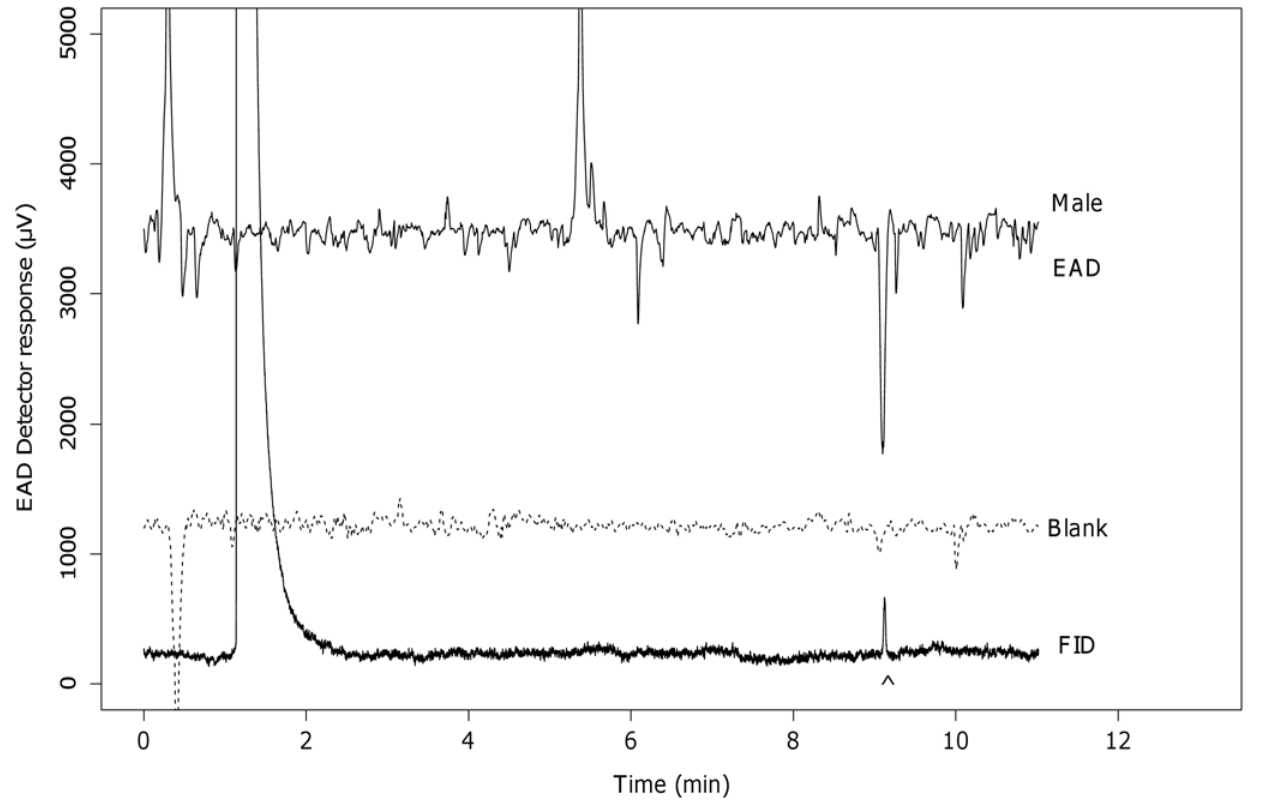
Fig 1. GC-EAD responses of male antennae to gland extracts. The arrow indicates the peak of interest in the FID signal. Bottom is the response to the blank. (EAD response at 9.11 min: 1884 ± 435 μ V, mean ± SE, N =